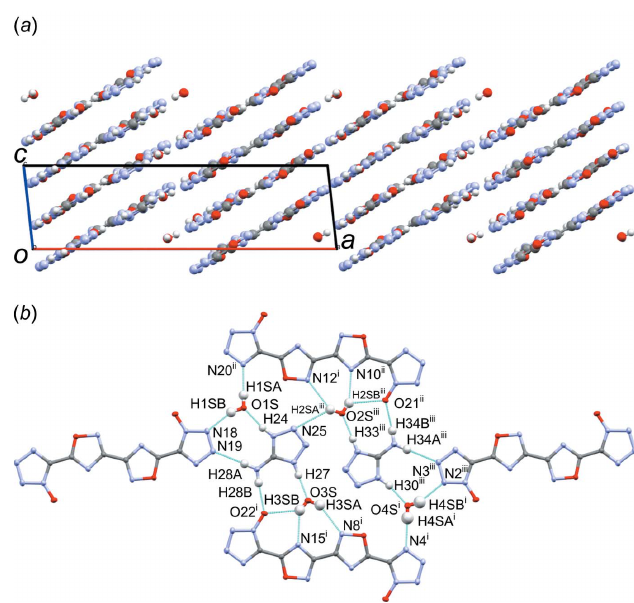
Figure 9 ( a ) Sheet-like packing of 4 as seen down the b -axis, showing the extended sheets containing both the dianion and the associated coplanar cations and solvent water, and ( b ) view highlighting the extensive in-plane hydrogen-bonding network between 5-aminotetrazolium, the surrounding dianions, and incorporated water molecules (intermolecular contacts). [Symmetry codes: (i) (cid:3) x , y + 1 (iii) x (cid:3) 1, y , z (cid:3) 2.]